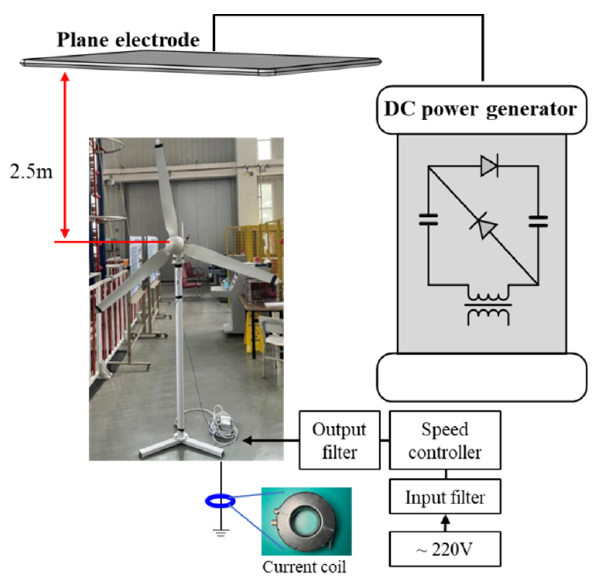
Figure 2. Experiment setup of corona charge measurement on scaled rotating wind turbine. A DC voltage of − 50 kV was applied to the plate electrode. A continuous and repetitive pulse discharge pattern of corona was generated when the blade remained static under the HV electrode, as shown in Figure 3.